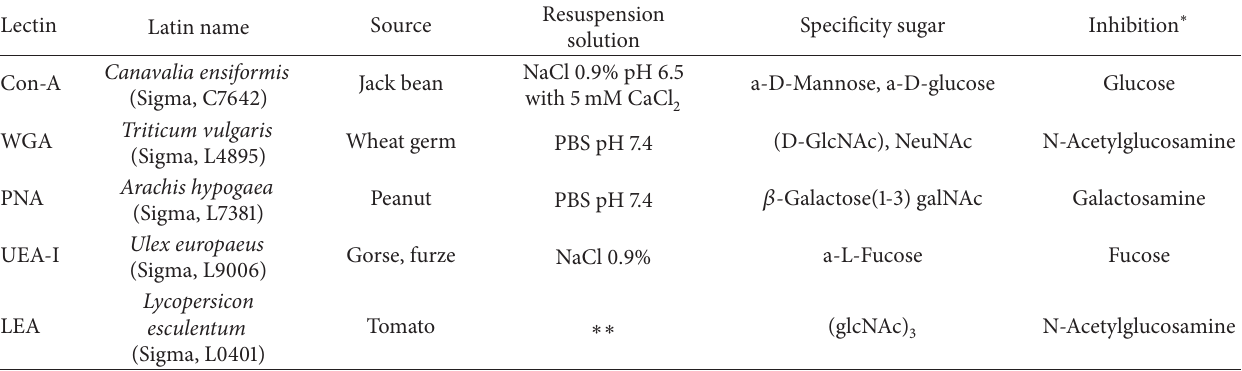
Table 1: Lectins used to investigate cell surface oligosaccharides domains in hemocytes and their competitive sugars used as controls for